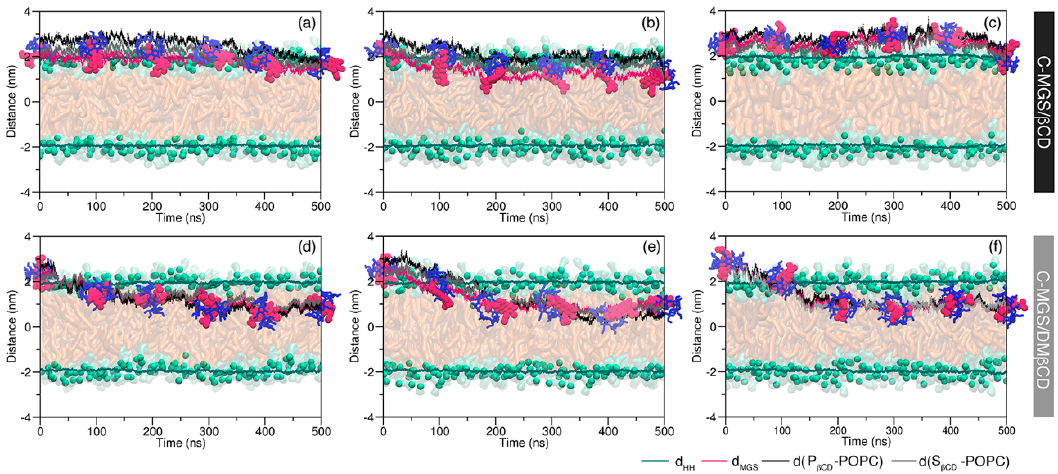
Figure 4. The distance of the center of the lipid bilayer (z = 0 nm) and inclusion complexes of C ‐ MGS as ( a – c ) C-MGS / β CD and ( d – f ) C-MGS / DM β CD. The average distance between the phosphate groups of each membrane leaflet (d HH ), the distance of the center of the lipid bilayer to the COM of MGS (d MGS ), primary rim of β CD (d(P β CD -POPC)) and secondary rim of β CD (d(S β CD -POPC)) are represented by green, pink, black, and grey lines, respectively.